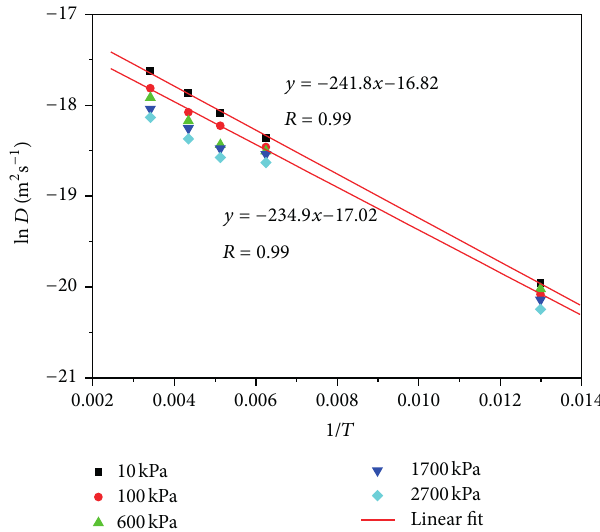
Figure 5: Arrhenius plots of the self-diffusion coefficients of hydrogen in NaX zeolite. The corresponding equations and least squares fits are given on the graphs.